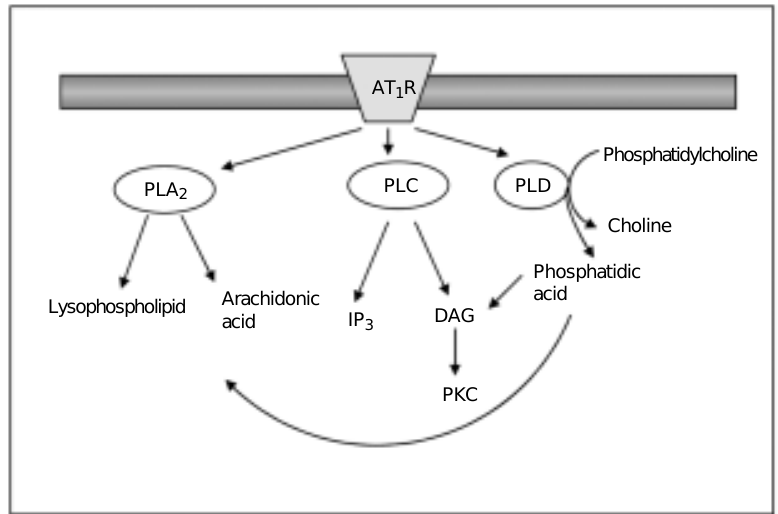
Figure 1. Phospholipid-derived second messengers resulting from Ang II-activated phos- pholipases. Shown are the major phospholipid-derived products from reactions catalyzed by phospholipase A (PLA), phospholipase C (PLC) and phospholipase D (PLD). AT 1 R = angio- tensin 1 receptor, IP 3 = inositol triphosphate, DAG = diacylglycerol, PKC = protein